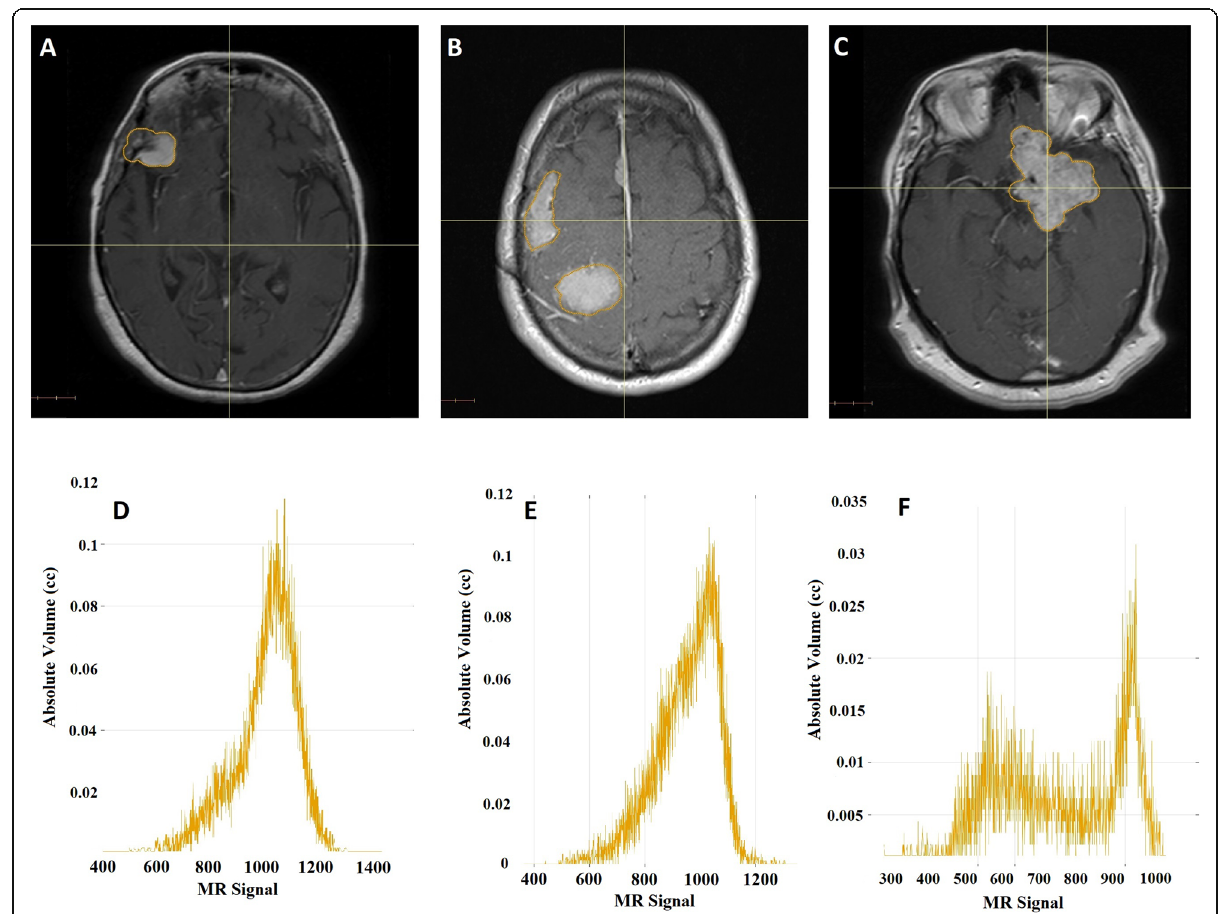
Fig. 2 The examples of post-contrast MRI images and T1-WI histograms obtained from different grades of meningioma tumors in one slice of brain. A T1-WI image with grade I (contoured with orange line). B T1-WI image with grade II (contoured with orange line). C T1-WI image with grade III (contoured with blue line). D A volumetric intensity histogram of grade I. E A volumetric intensity histogram of grade II. F A